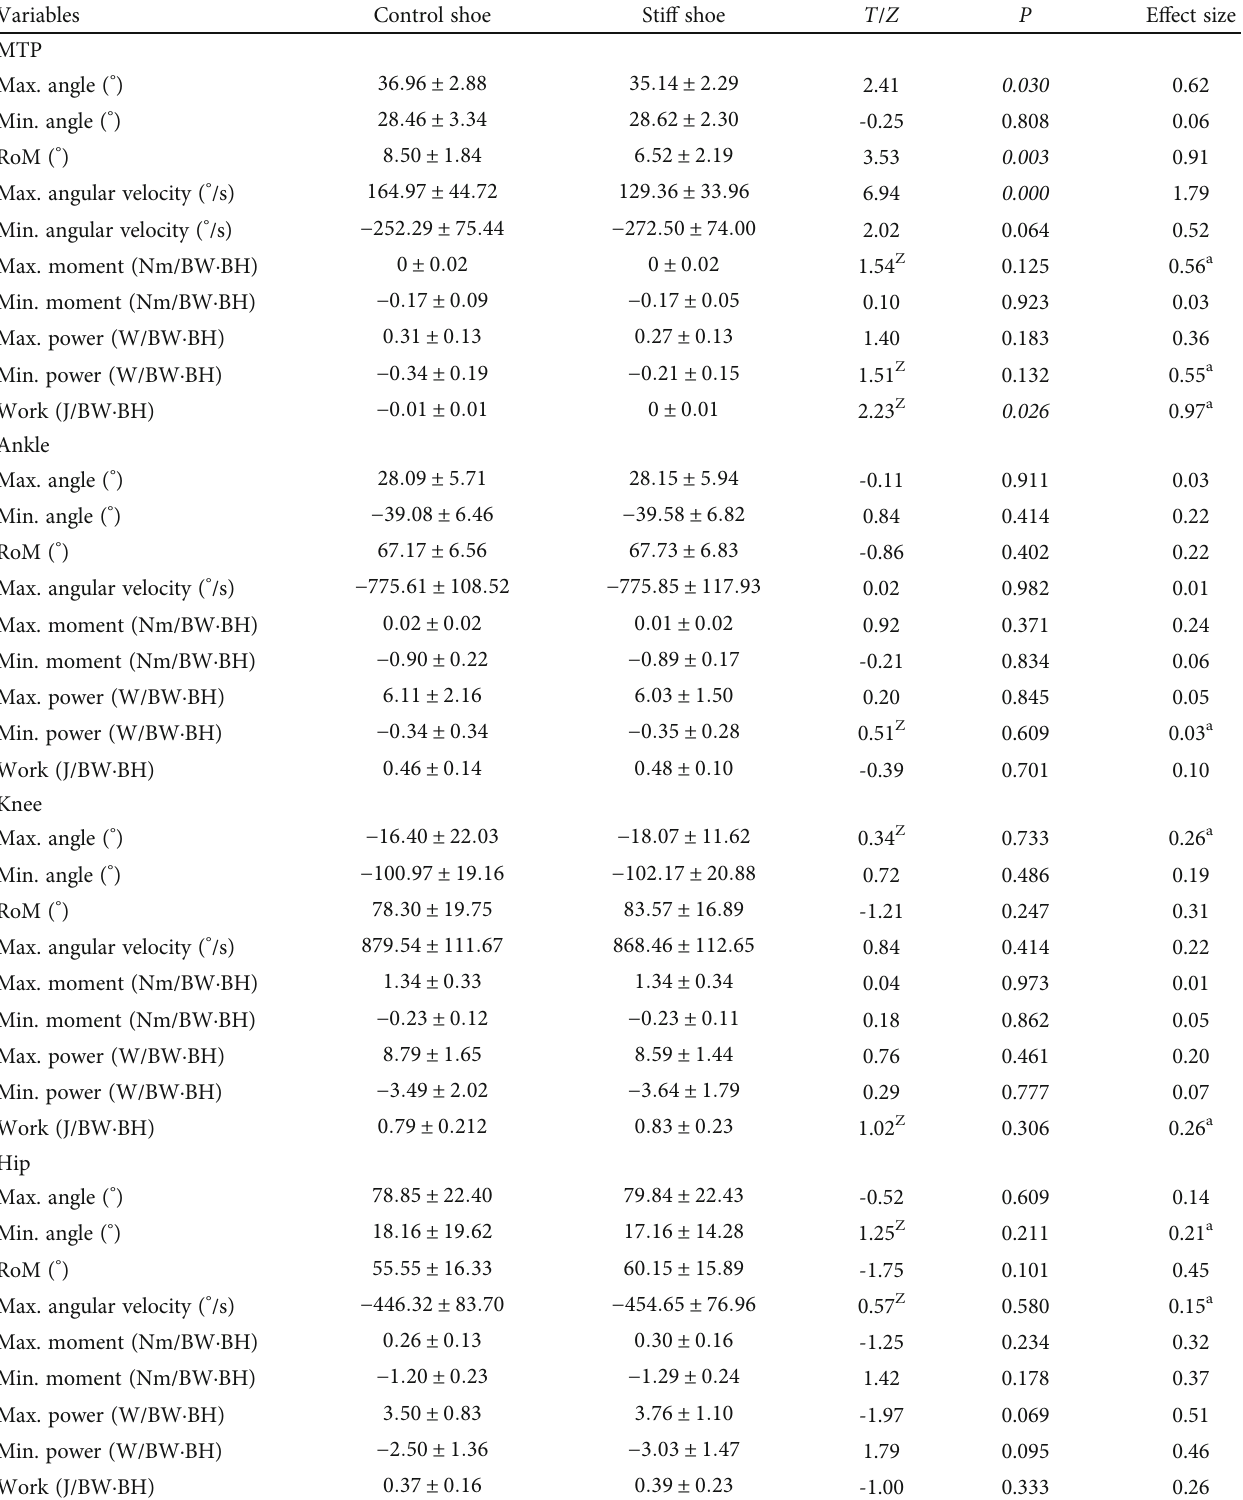
Table 3: Kinematics and kinetics of the MTP, ankle, knee, and hip joints during the take-o ff phase ( mean ± SD ).